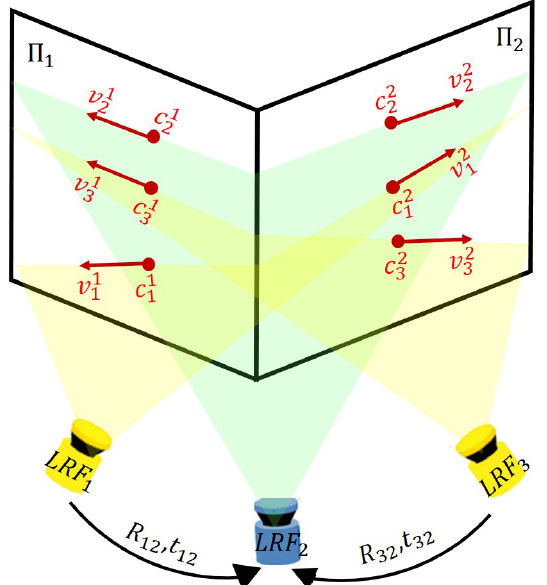
Figure 12. The coplanarity and orthogonality constraints established from a V-shaped